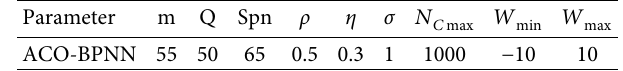
Figure 28: Comparison diagram before and after ACO optimization.